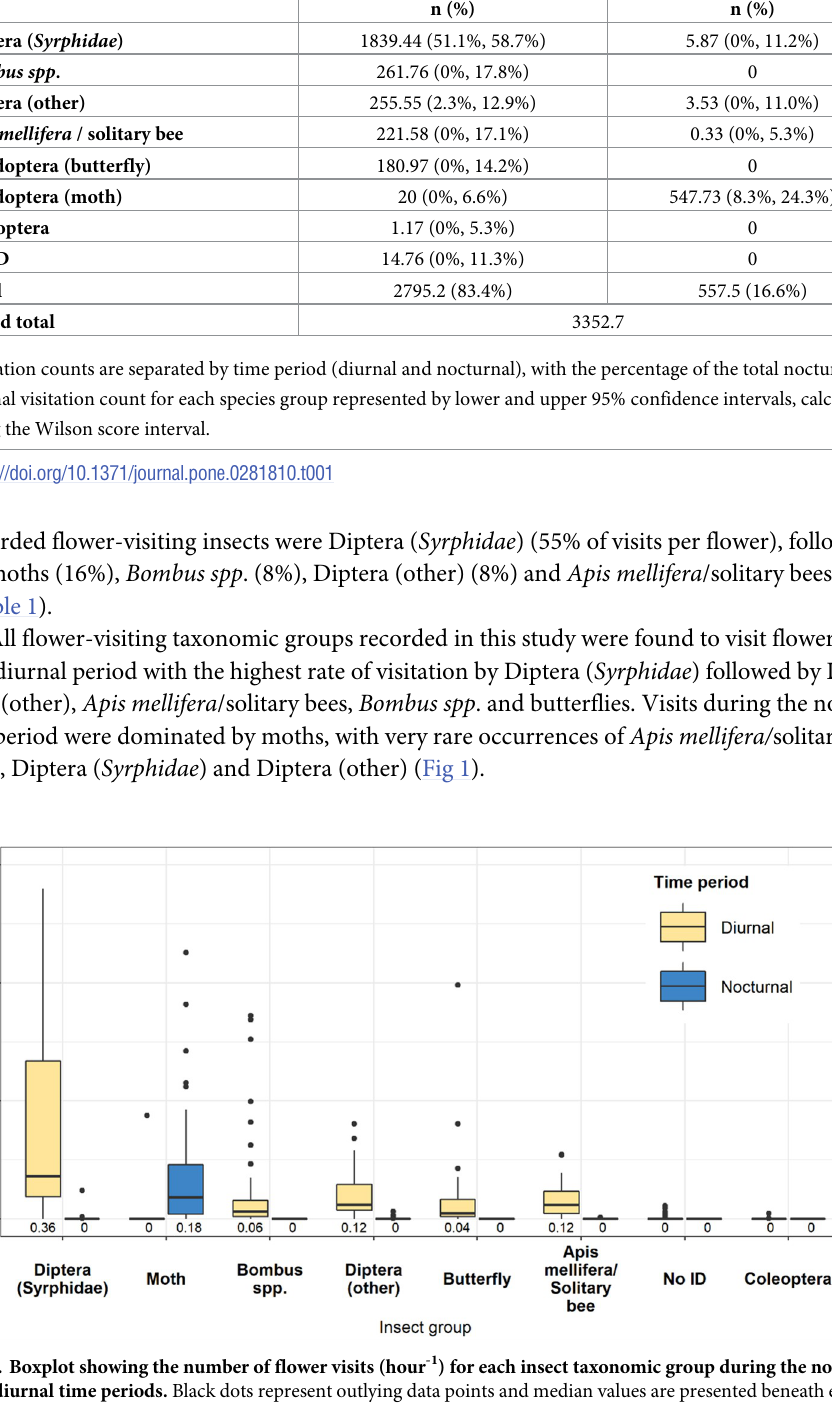
Table 1. Total number of visits (flower -1 ) for each insect group across all sites. Taxonomic group